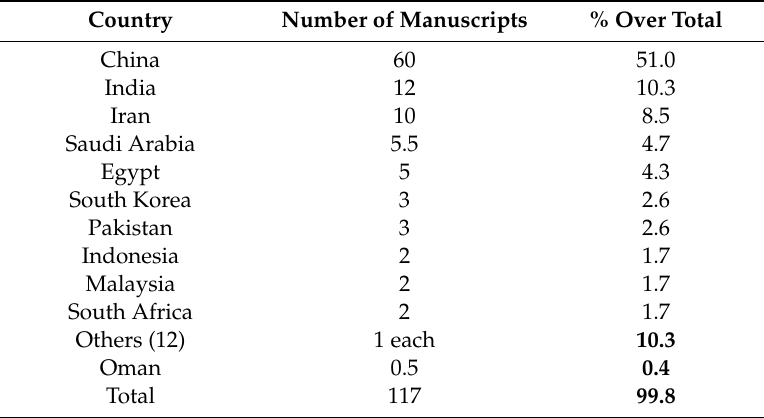
Table 6. Distribution by countries of manuscripts published in 2019 about Hg(II) adsorption.